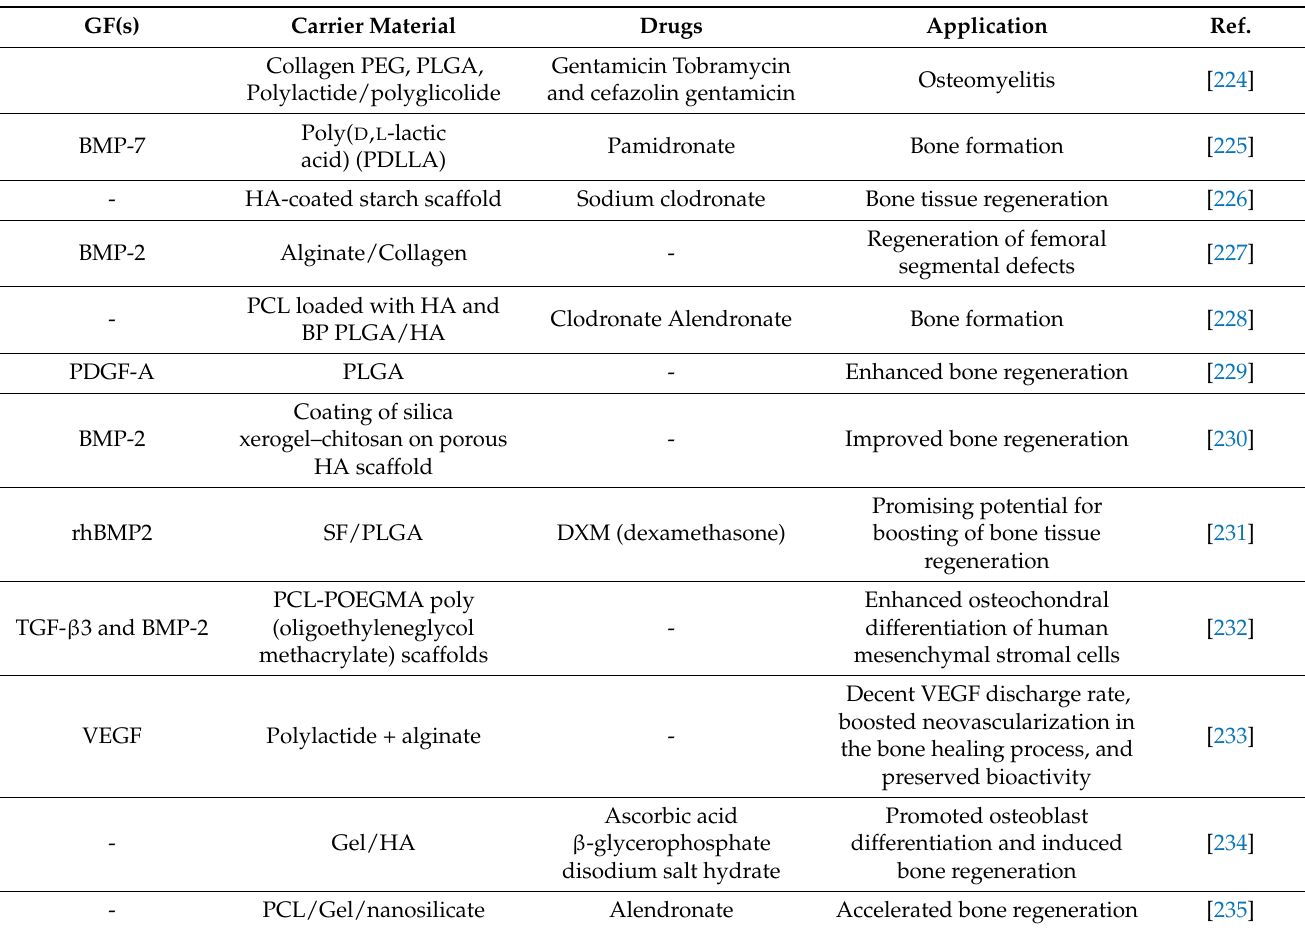
Table 3. List of nanofibrous scaffolds used in BTE for the release of drugs and